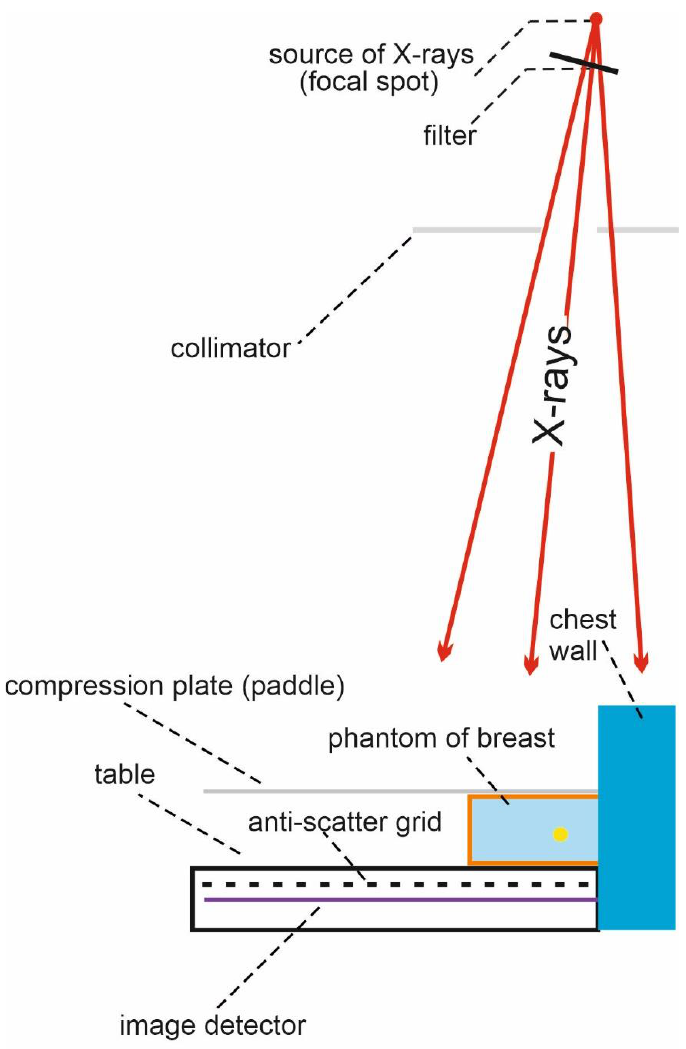
Figure 1. The scheme of simulated system.